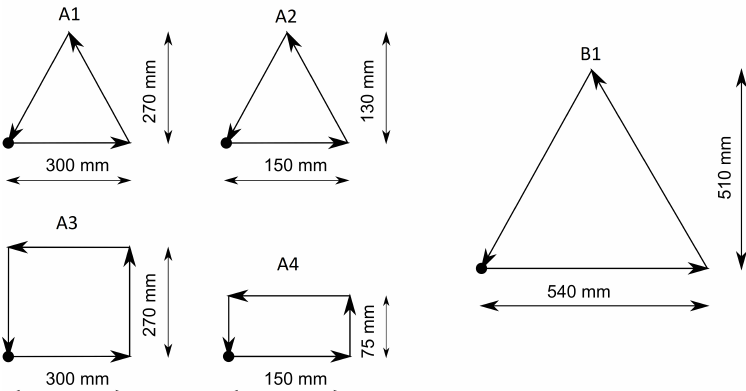
Figure 7. Figures programmed in the robot.